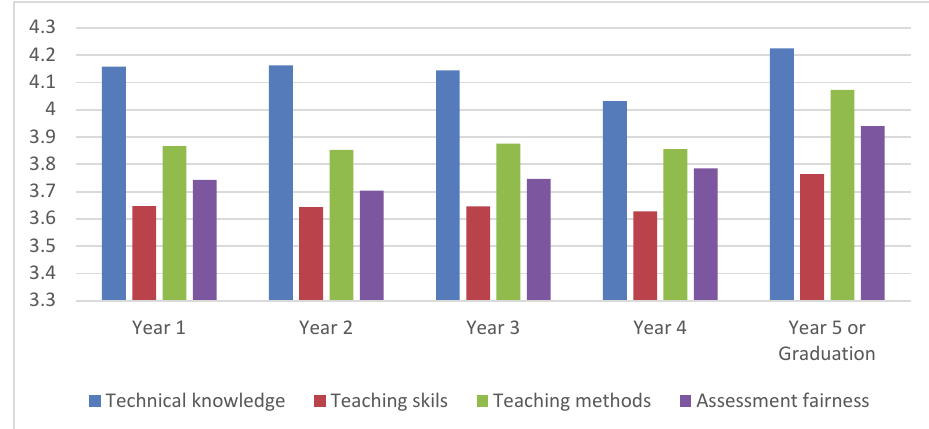
Fig. 1. Assessment of teaching quality among students in different school